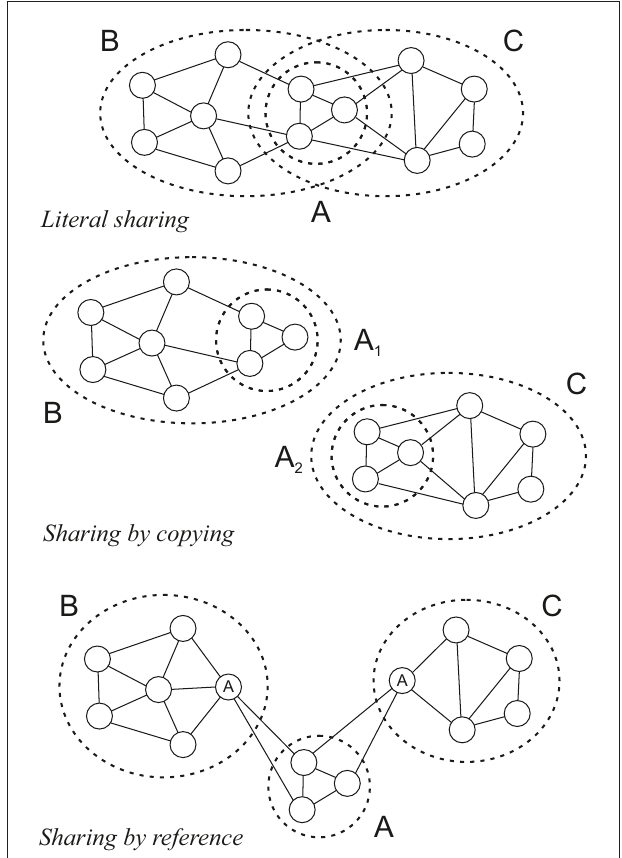
FIGURE A1 | Three possible ways in which cell assemblies may be shared, as described in the text. Adapted with permission from Wolff (2006, Figure